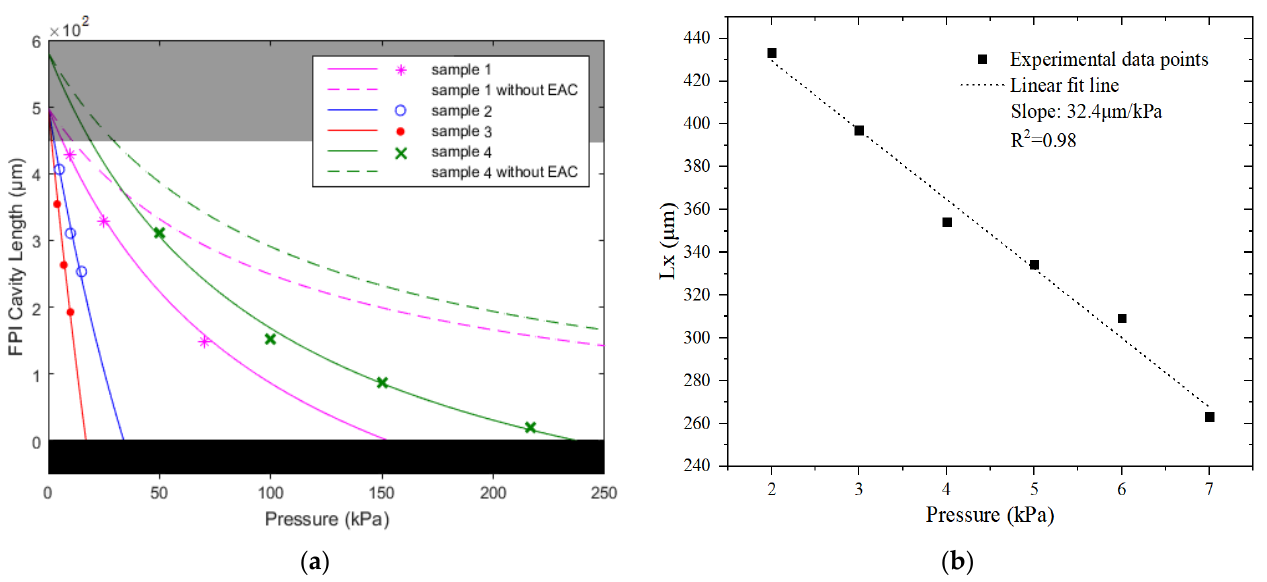
Figure 4. ( a ) Simulation results of the L x − P relation (lines) and experimental results (points). ( b ) Experimental results of sample-3.